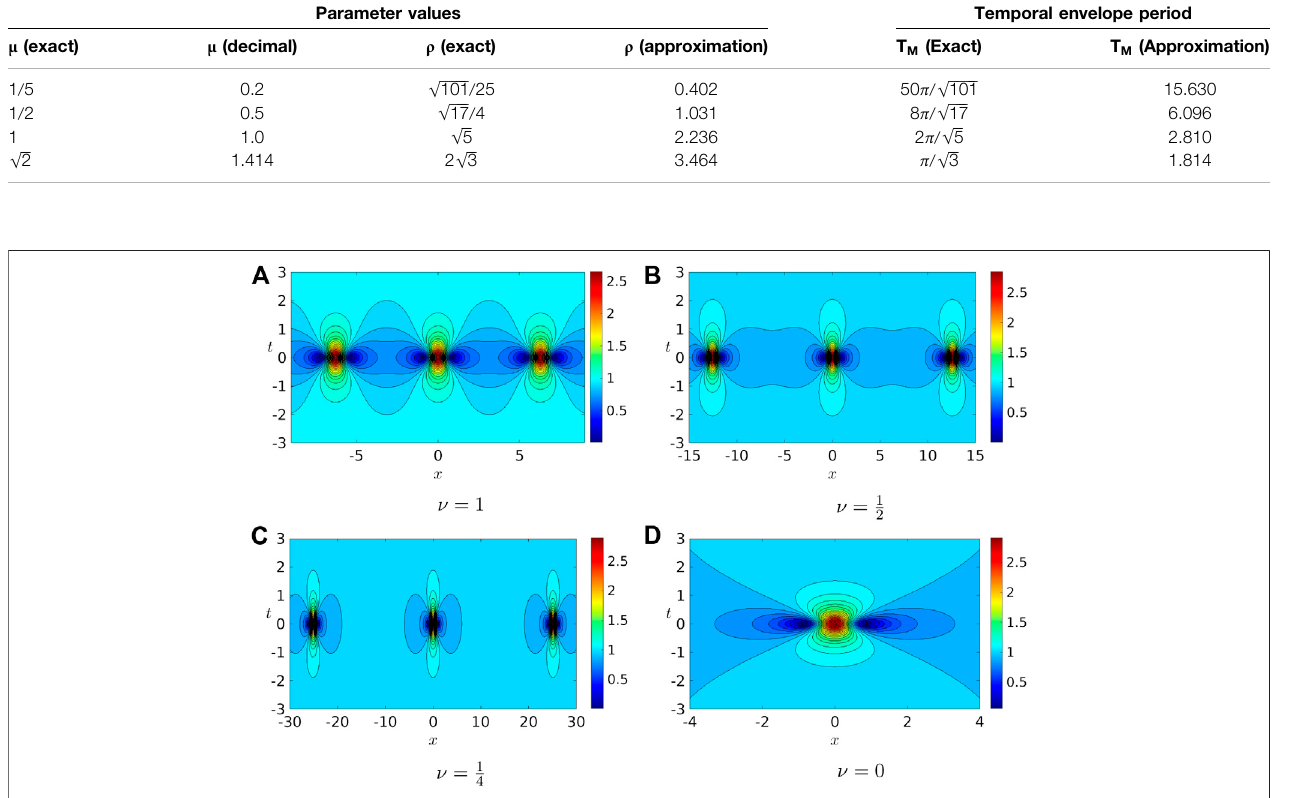
TABLE 1 | Exact values of the temporal envelope period T M and their approximate values for selected parameter values μ corresponding to the Kuznetsov-Ma breather. Parameter values Temporal envelope period